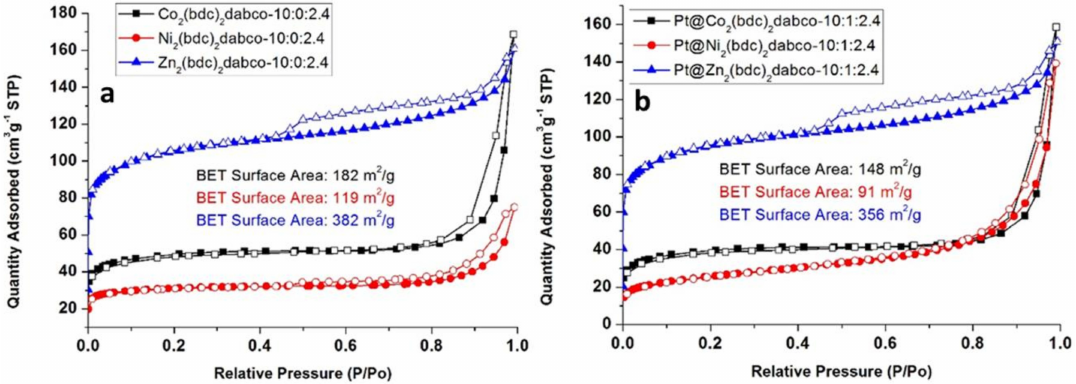
Figure 3. BET analysis of ( a ) M/C and ( b ) Pt@M/C